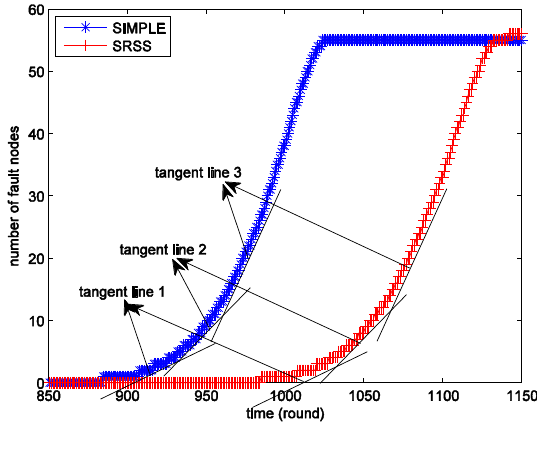
Figure 4. The average number of fault nodes in different time for the